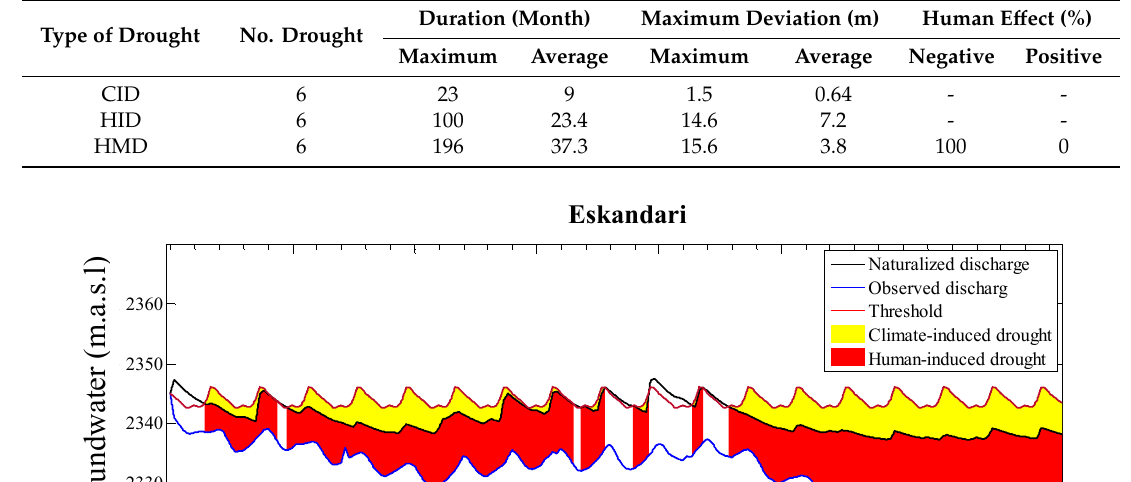
Table 6. Groundwater drought in Eskandari (threshold = 80th percentile).